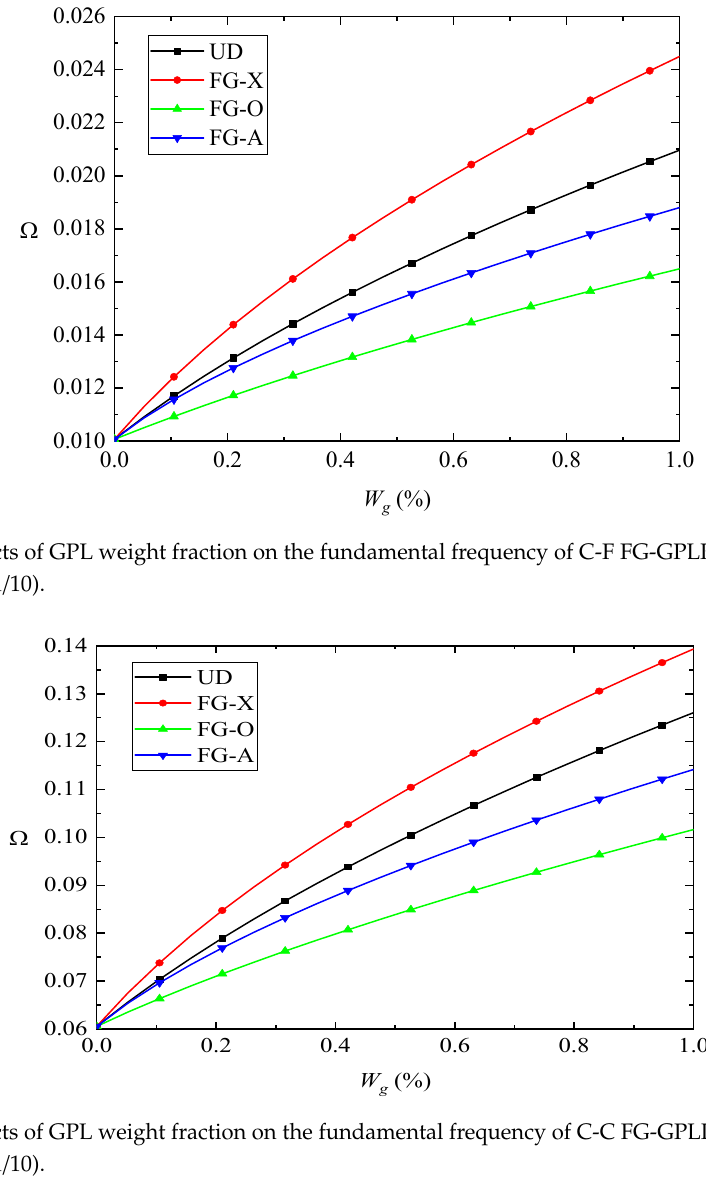
Figure 3. Effects of GPL weight fraction on the fundamental frequency of S-S FG-GPLRC circular arch ( θ 0 = π/3, λ = 1/10).